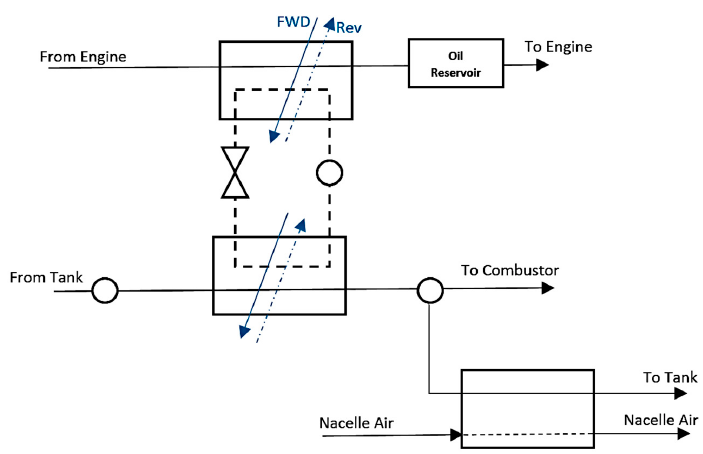
Figure 7. Thermal management system embodiments with working fluid and reversible pump. FWD: Forward, Rev: Reverse.